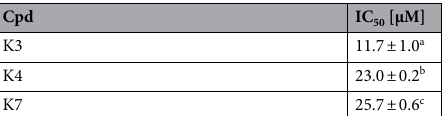
Table 6. The modulation of the verapamil-stimulated (100 µM) P-glycoprotein ATPase activity by selected ketone-selenoesters. Data are expressed as the average inhibitory concentration (IC 50 ) of three repetitions with standard error of the mean (SEM). The statistical differences between compounds were calculated by one-way analysis of variance (ANOVA) and Duncan’s post hoc test (p ˂ 0.05), where significances were denoted by different letters